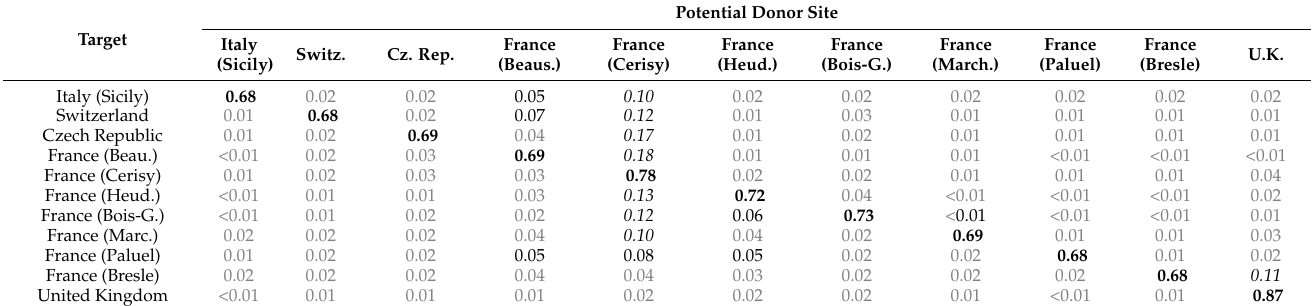
Table 5. Bayesian modelling of potential bias in direction of dispersal (gene flow) among the 11 populations of Anax imperator in Europe. Numbers represent the proportion that disperses between sites (bold indicates self-recruitment). Values <0.05 (5%) are in grey. Italic indicates pairs of sites with ≥ 10% exchange. These values represent historical gene flow, and do not provide any information about contemporary levels of dispersal among sites.